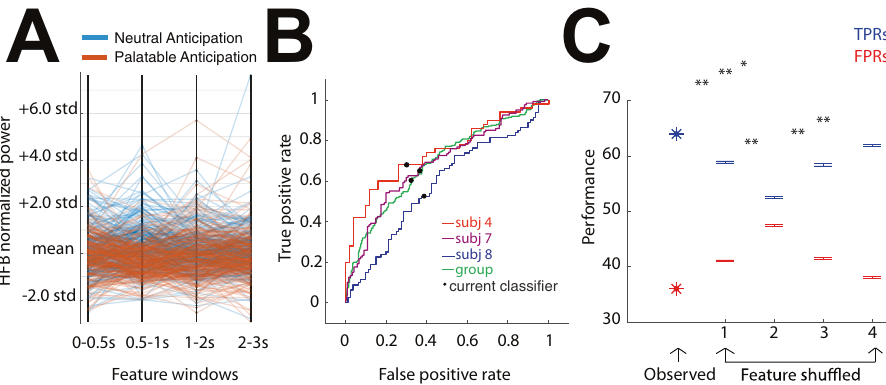
Fig. 3 Posterior insular HFB activity is suf fi cient to classify between anticipation for palatable and taste-neutral solutions on a single trial basis. A Parallel coordinates plot displaying normalized HFB power for each observation ( n = 250 taste-neutral and n = 250 palatable trials) as a function of the four features used (4 anticipation time epochs: 0 – 0.5 and 0.5 – 1 s of cue presentation, and 1 – 2 and 2 – 3 s of post-cue fi xation). Note that at the second feature, a cluster of taste-neutral anticipation trials is observed. B Inter (green) and intra-individual Receiver Operating Curves (ROCs) for positive class 1 (neutral anticipation). Inter-individual mean TPR (True Positive Rate) and FPR (False Positive Rate) and AUC (Area Under the Curve) were 64%, 36, and 69%, respectively. Intra-individual mean TPR and FPR, and AUC for the three subjects were (4) 69%, 31%, and 74% (7) 64%, 36%, and 69%, and (8) 57%, 43%, and 58% respectively. C Statistical testing on classi fi er performance (TPR in blue, FPR in red). The fi rst set of values represent group classi fi cation performance on observed data: 64% mean TPR and 36% mean FPR across the two classes. Same performance measures were computed following permutations ( n = 100) of values for a given feature across the two classes. Shuf fl ed features 1, 2, 3, and 4 values yielded the following mean TPR and FPR values: (1) 58.84%, 41.06, (2) 52.56, 47.46, (3) 58.43, 41.46, and (4) 61.94, 38.06. Error bars represent S.E.M. across performance measures